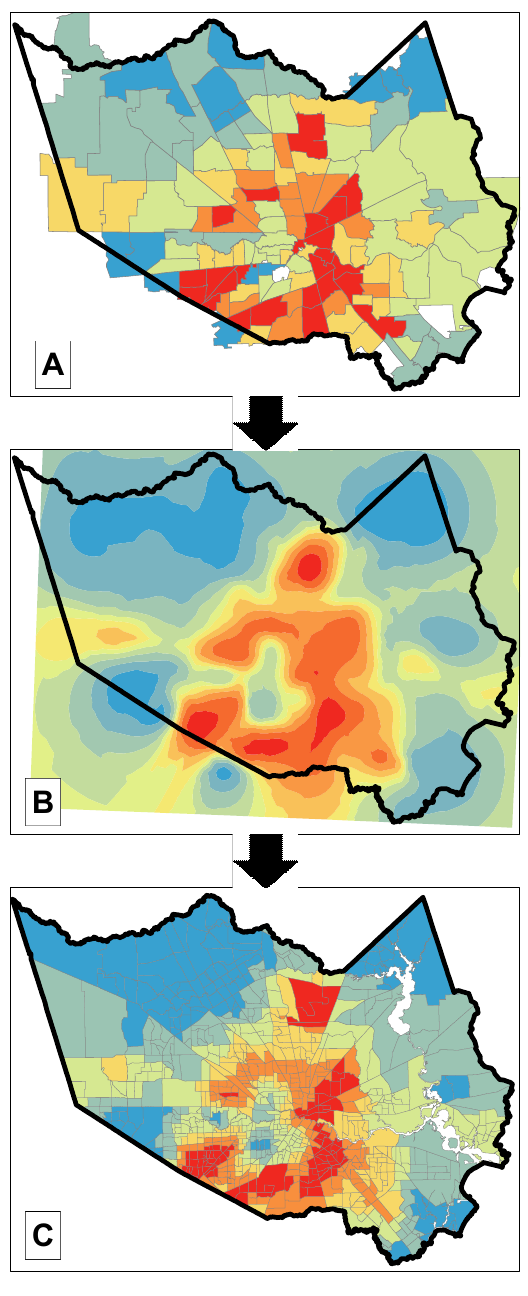
Figure 1. Predicting COVID-19 incidence at the census tract level. Steps involved in the disaggre- gation of zip-level COVID-19 community incidence data (observed data) to census tract estimates (predicted data) using the areal interpolation toolset in Esri’s ArcGIS Pro. ( A ) Observed data provided by the county: cases per 10,000 population at the zip code level. ( B ) Transform zip code level data to a prediction surface by using areal interpolation techniques. ( C ) Use the newly created prediction surface to estimate prevalence at the census tract level.